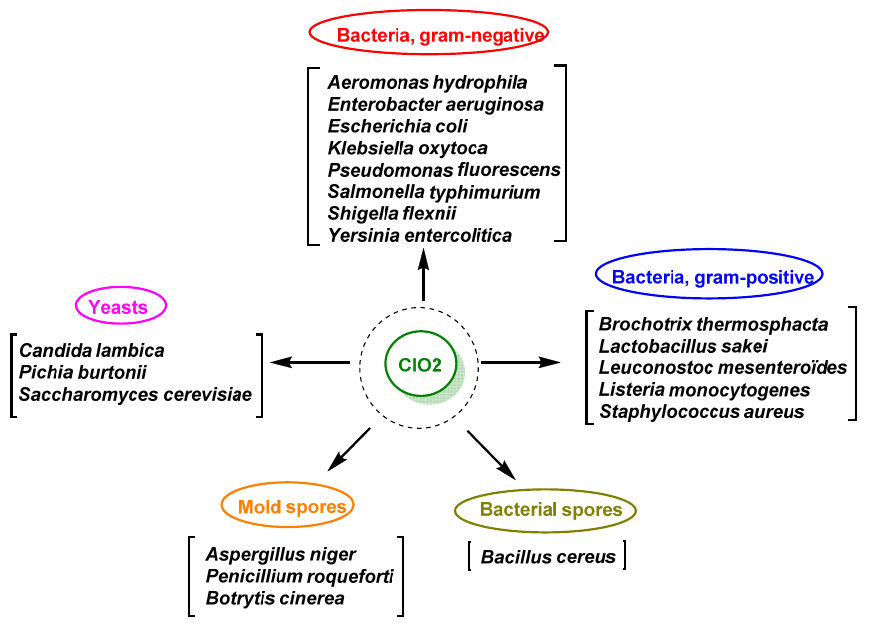
Figure 46. ClO 2 antimicrobial spectrum of activity.